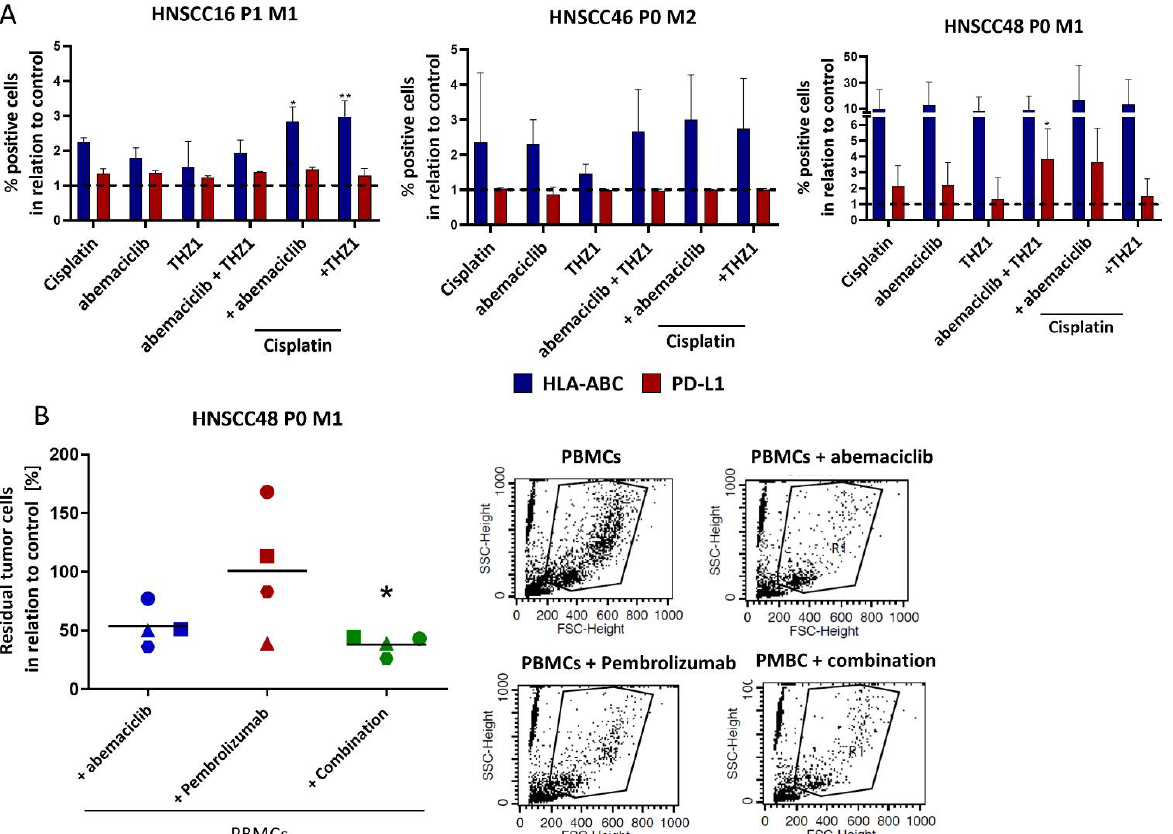
Figure 7. Phenotyping and allogenic co-culture. ( A ) Phenotyping was carried out after 2 × 72 h treat- ment. Drug doses were: abemaciclib [HNSCC16 P1 M1/HNSCC46 P0 M2: 1 µM, HNSCC48 P0 M1: 0.1 µM], THZ1 [HNSCC16 P1 M1/HNSCC48 P0 M1: 20 nM, HNSCC46 P0 M2: 10 nM], and Cisplatin [HNSCC16 P1 M1/HNSCC46 P0 M2: 1 µ g/mL, HNSCC48 P0 M1: 0.05 µ g/mL]. Cells were